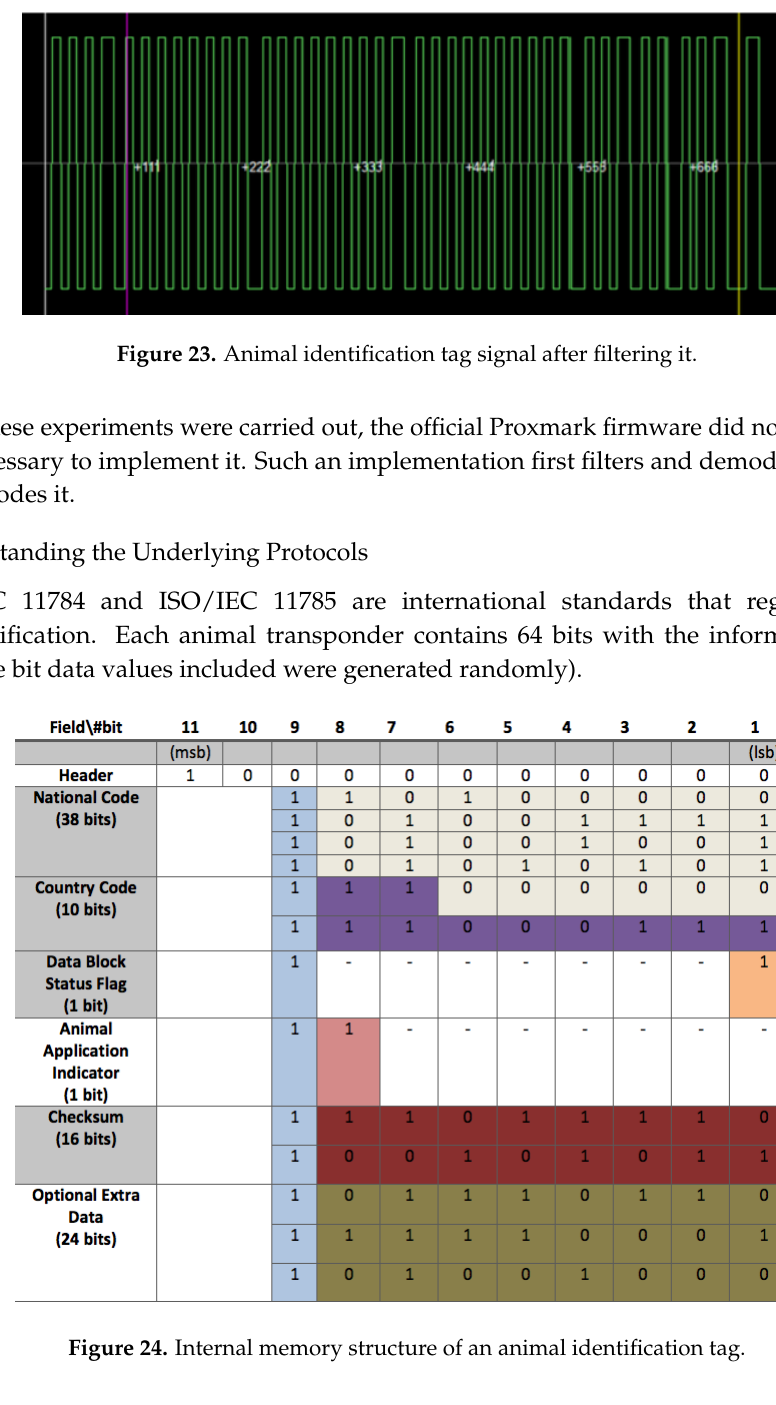
Figure 22. Noisy signal from an animal identification tag.